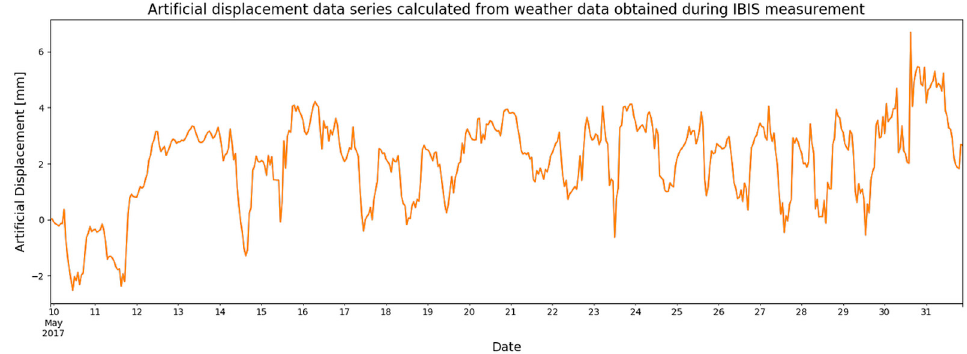
Figure 18. Apparent displacement data series calculated from the weather data obtained during the IBIS measurements.